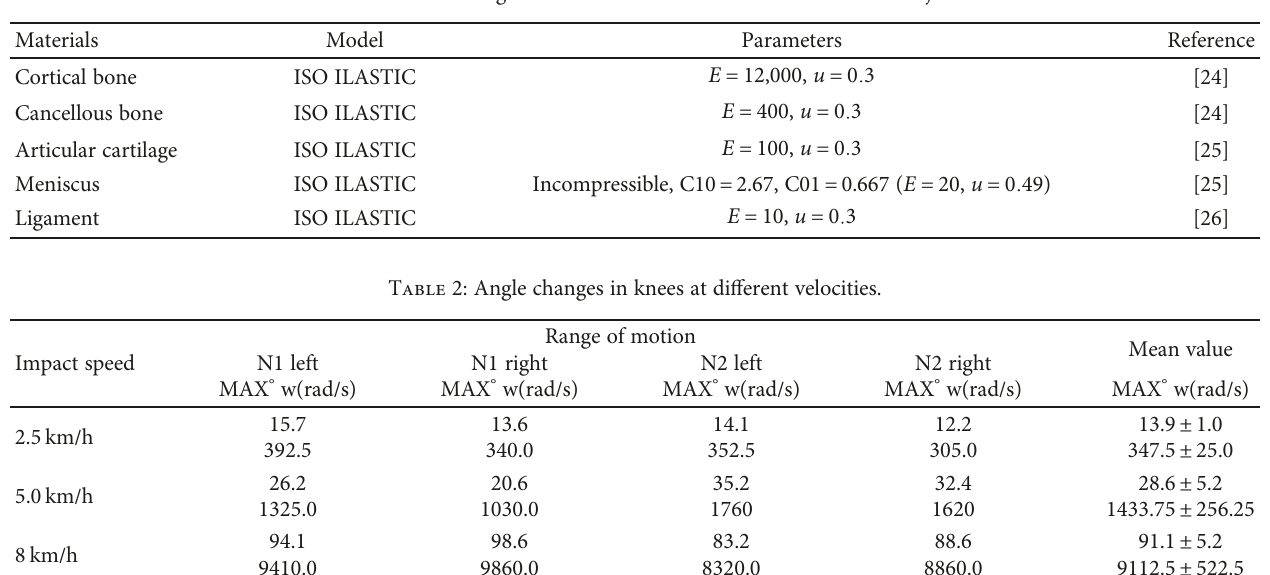
Table 1: Material assignment of the fi nite element model of the knee joint.